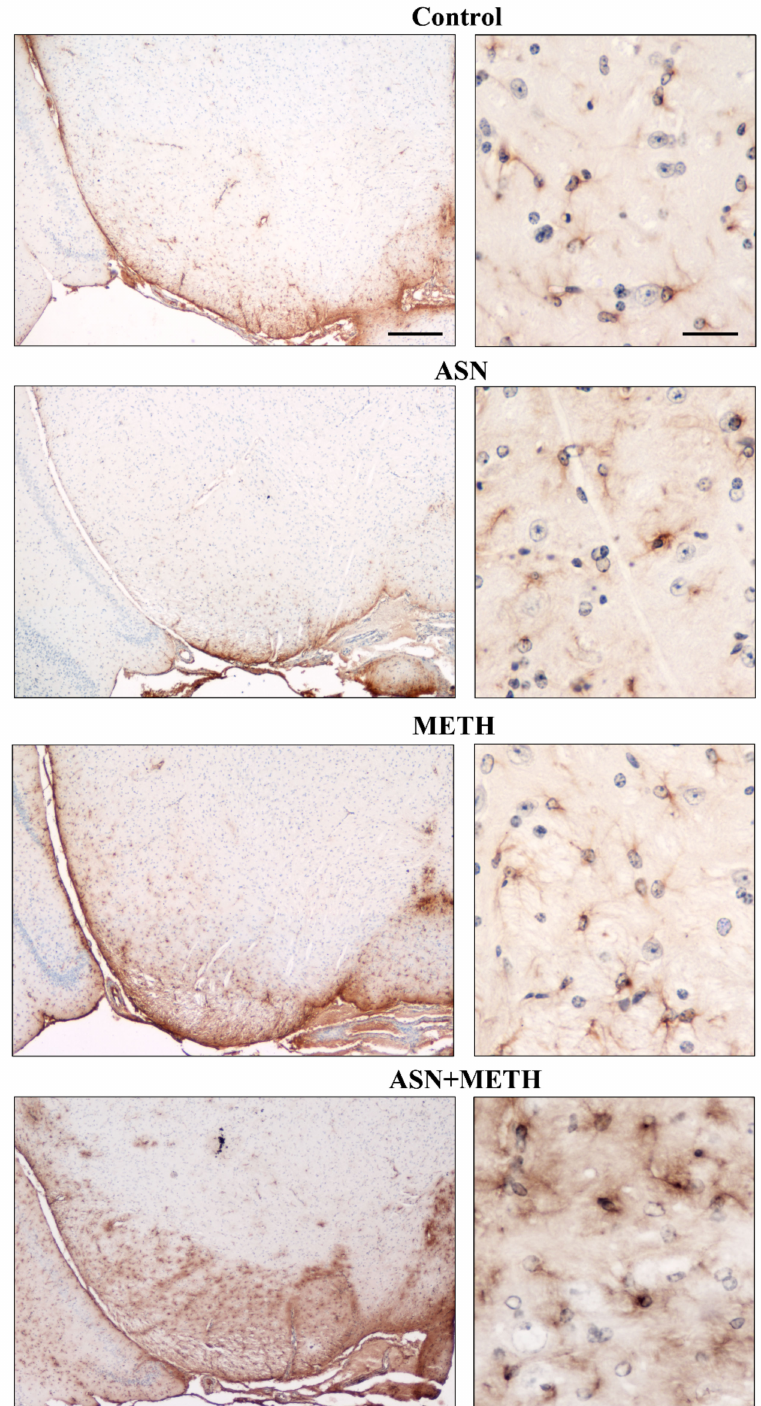
Figure 10. Representative pictures of GFAP immunostaining within SNpc and VTA. Combined treatment with ASN + METH increases GFAP immunostaining within SNpc and VTA. Scale bar (low magnification) = 250 µ m; scale bar (high magnification) = 40 µ